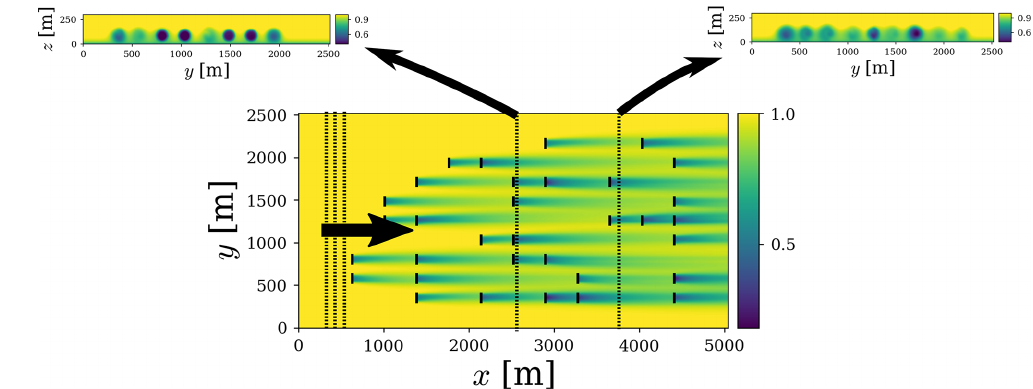
Figure 1. Schematic of the computational strategy used to solve Eq. (18). Dashed lines denote the location of a subset of planes, and big arrow shows the marching